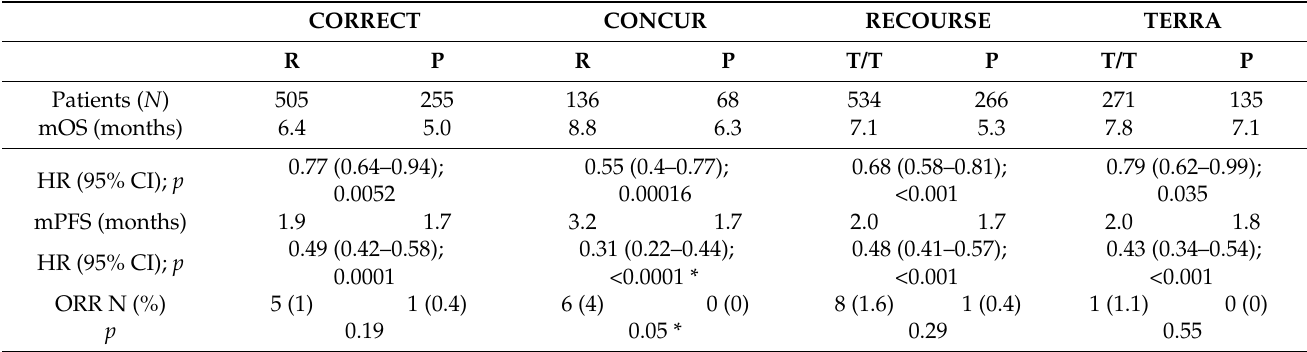
Table 1. Key phase III efficacy data of regorafenib and